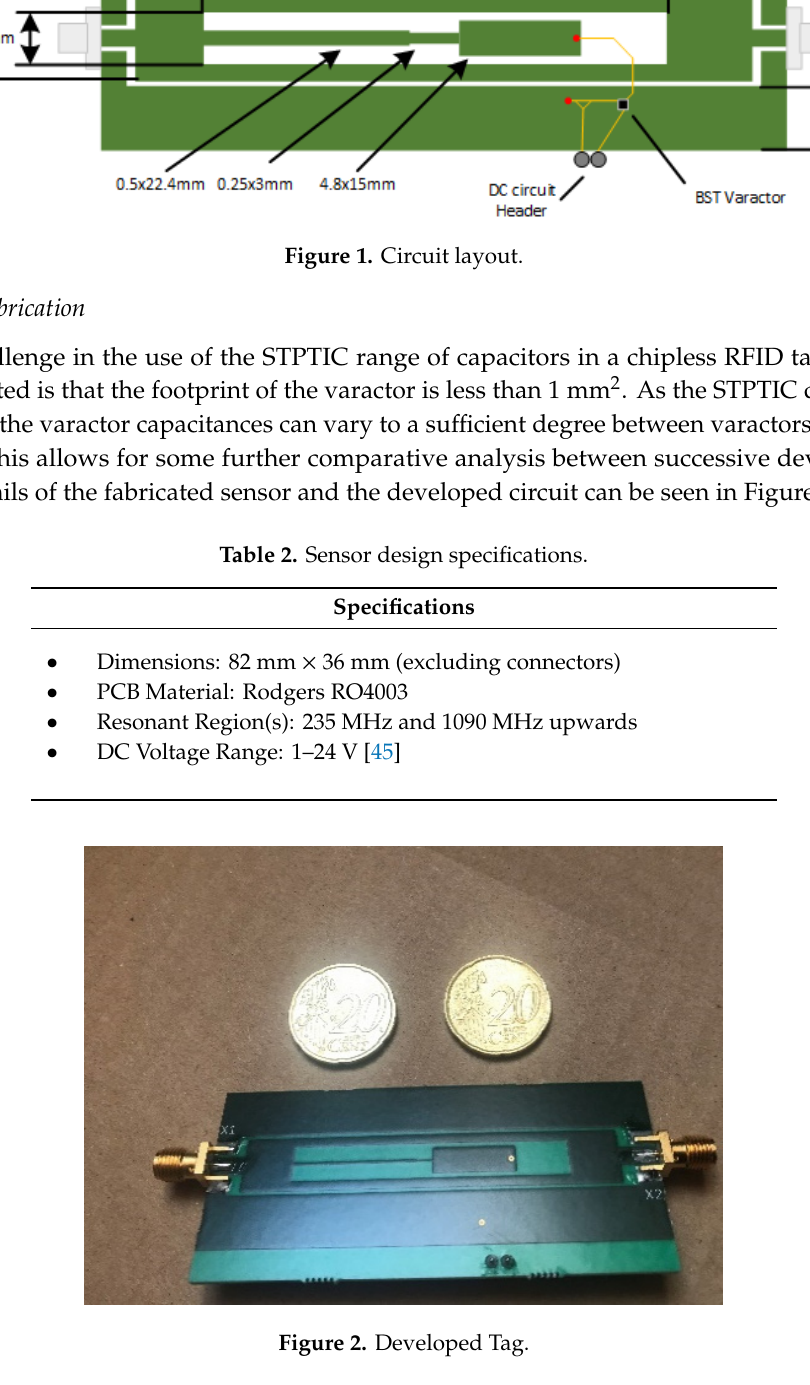
Figure 1. Circuit layout.